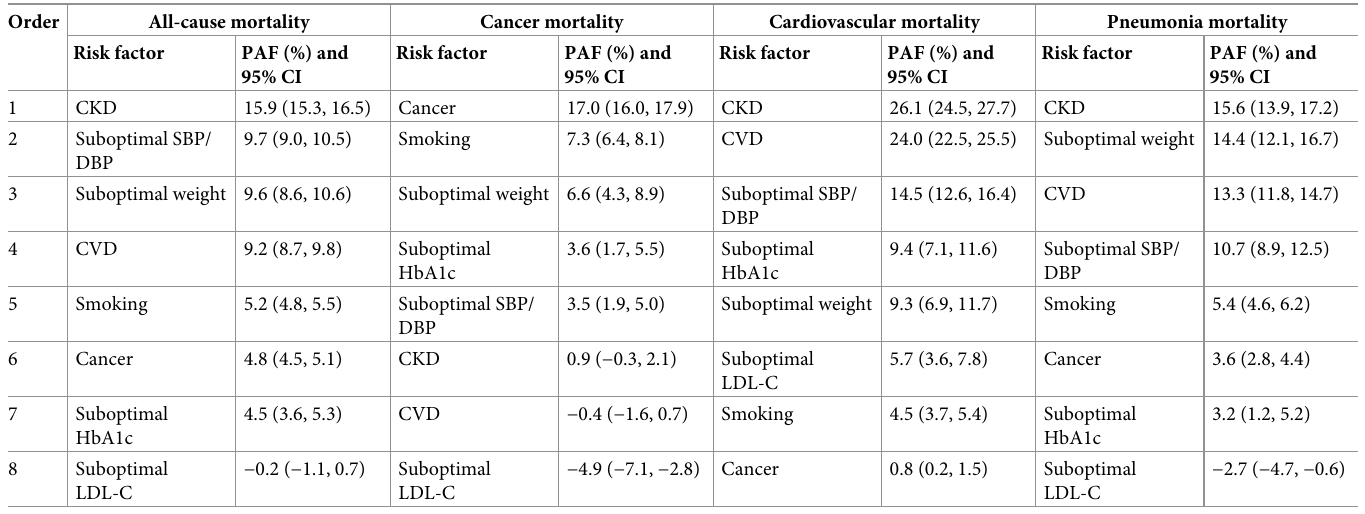
Table 2. Rank order in PAFs of risk factors for all-cause and selected cause-specific mortality in people with type 2 diabetes.